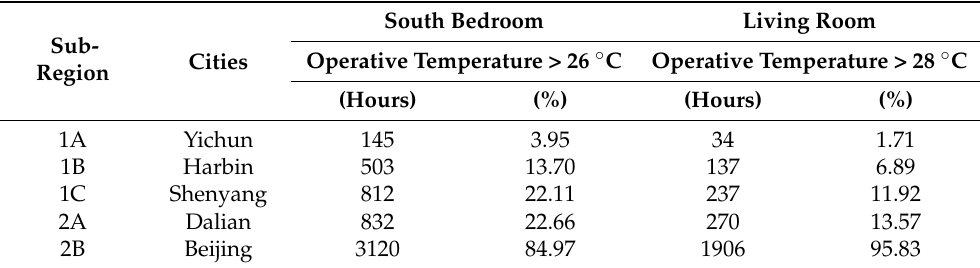
Table 11. South bedroom and living room overheating assessment based on CIBSE Guide